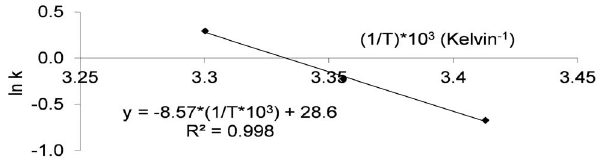
Figure 2. Arrhenius representation for the laboratory powder (Lcr35 H bacteria). The observed k values were previously obtained with ln(N t /N 0 ) against time for the laboratory powder (Fig. 1). These k values (y axis) were represented against 1/T (Kelvin 2 1 ) (x axis) to obtain the Arrhenius equation of this assay (Equation 4).